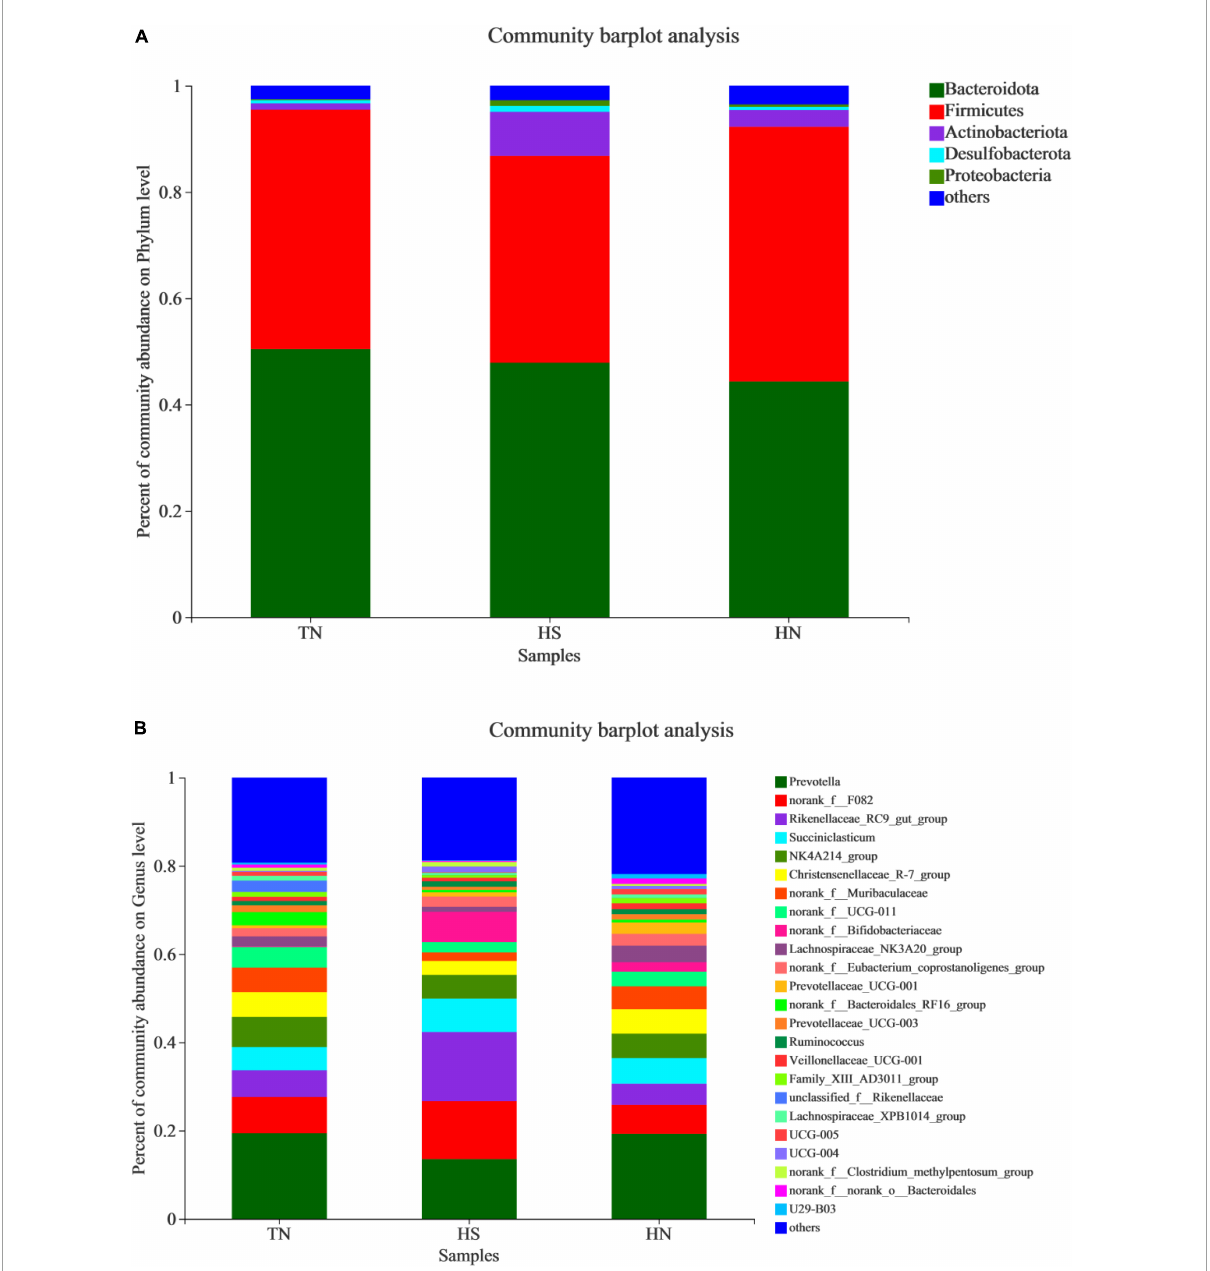
FIGURE3 Relative abundance distribution of rumen flora at (A) phylum and (B) genus levels. TN: the basal diet, thermoneutral condition ( n = 4); HS: the basal diet, heat stress environment ( n = 4); HN: the basal diet supplemented with 800 mg/kg NA ( n = 4).